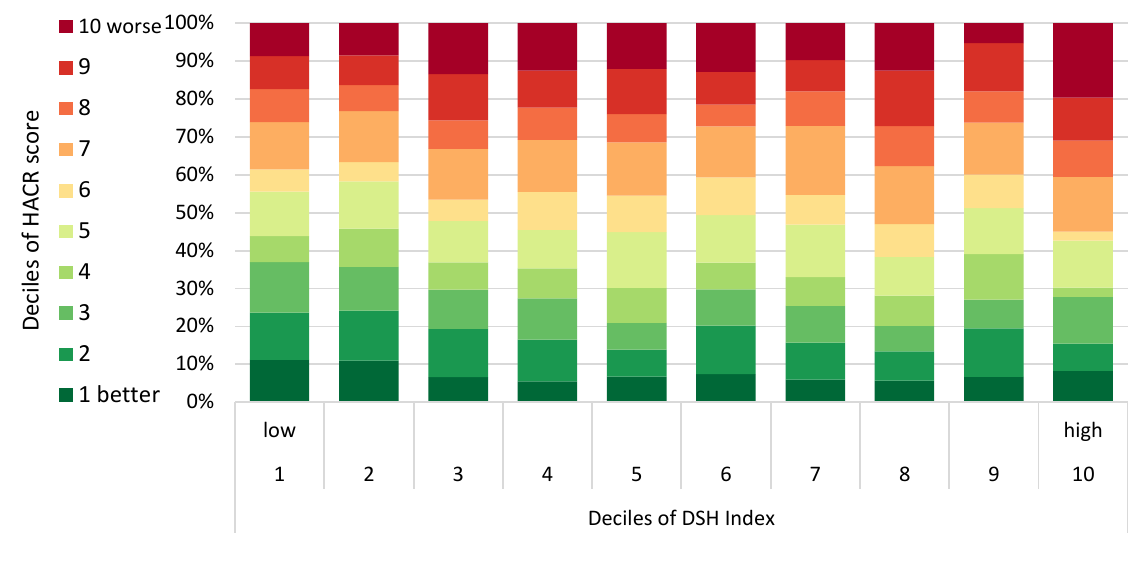
Figure 6.2 Distribution of Total HAC Scores by DSH